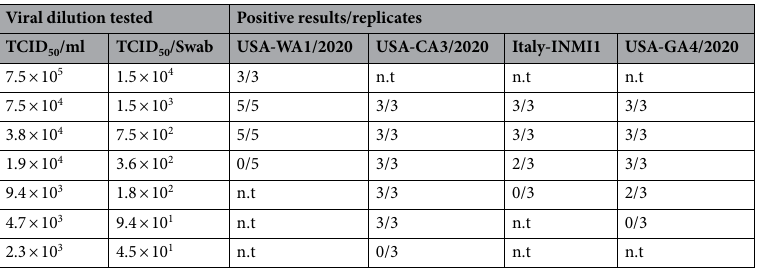
Table 1. SARS-CoV-2 live virus limit of detection. TCID 50 50% tissue culture infectivity dose, n.t . not